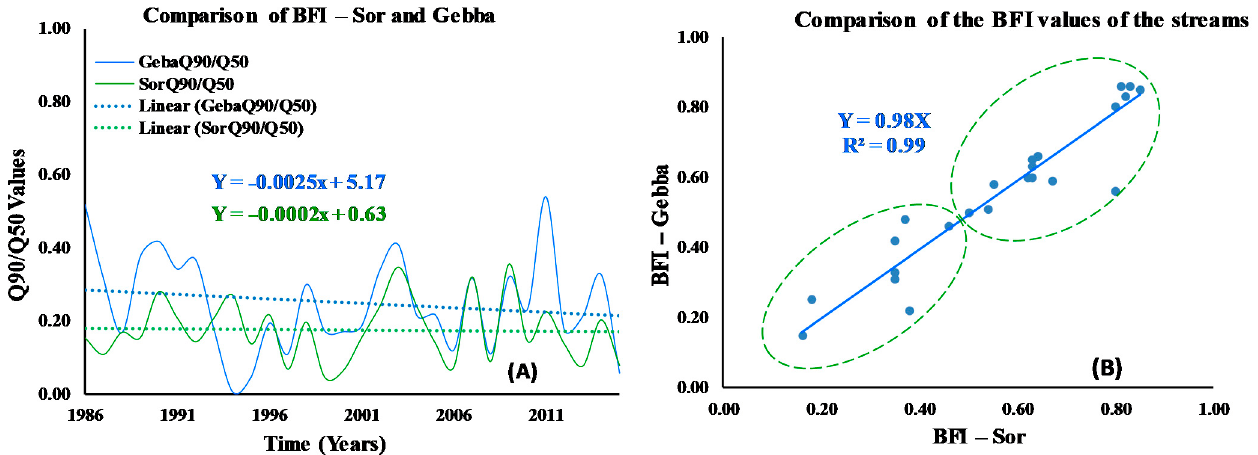
Figure 21. Comparison of the Sor and Gebba streams. ( A ) BFI from FDC, (B ) BFI of all methods. Table 7. Summary of methods, parameters, and BFI values for selected baseflow separation techniques.